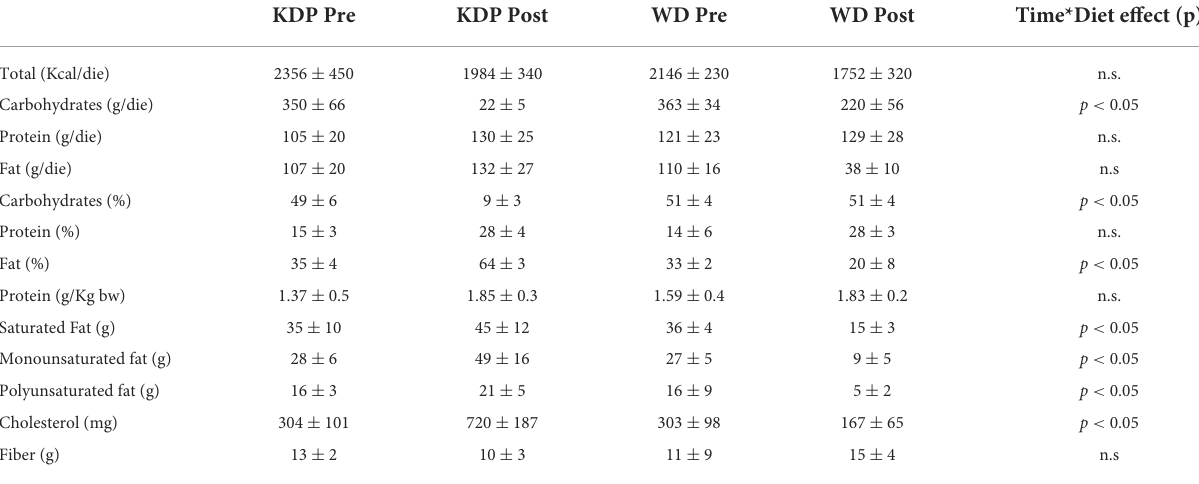
TABLE 2 Daily dietary energy and nutrient intake at baseline and during KEMEPHY diet (KDP) and Western Diet (WD).